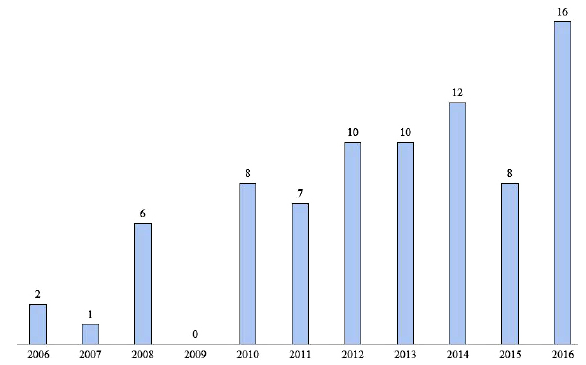
Fig. 2 . Number of articles by publication